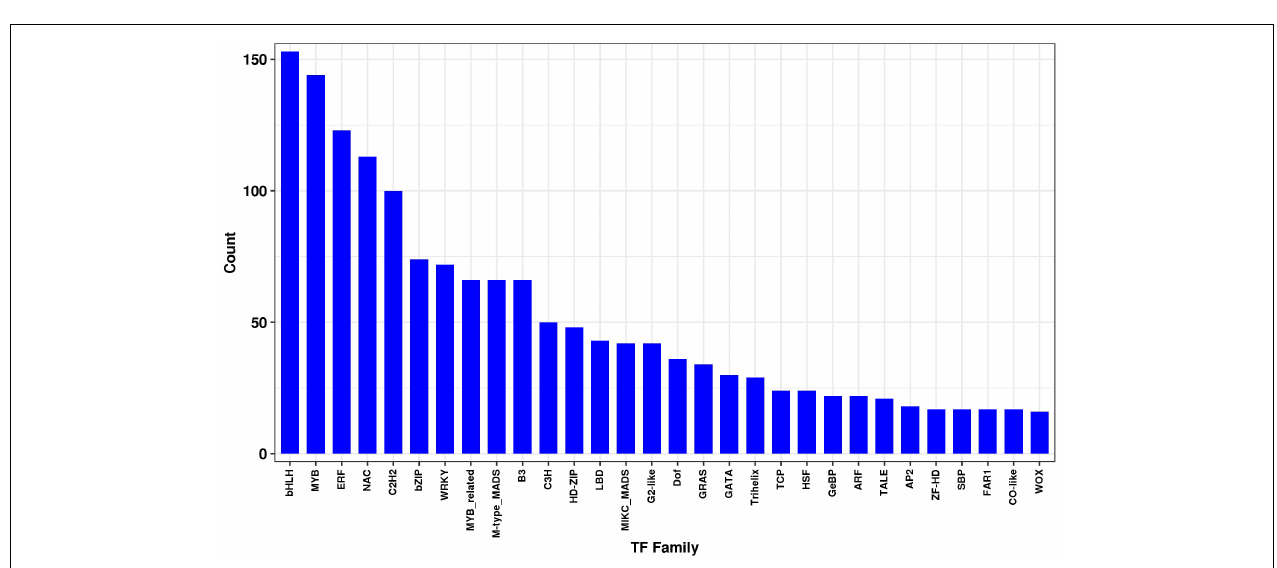
FIGURE 8 | Gene ontology (GO) (A) and KEGG pathway-rich analysis (B) . Based on the GO-rich and KEGG results, the extent of richness is measured by the rich factor, false discovery rate (FDR) values, and the number of genes that were collected into this GO term or KEGG pathway. Rich factor refers to the ratio of the number of different genes collected in the GO term or KEGG pathway to the number of genes annotated.